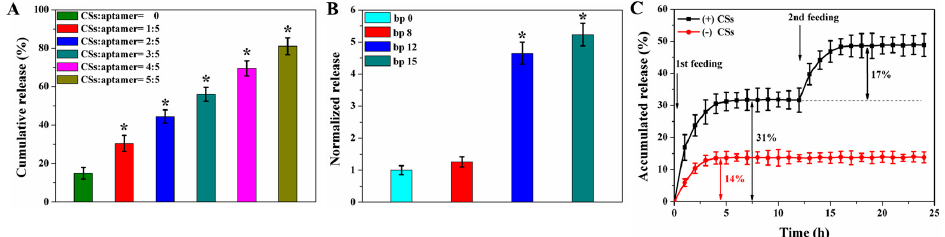
Figure 6. ( A ) Effect of molar ratio of CS15 to aptamers on thrombin release. The concentration of